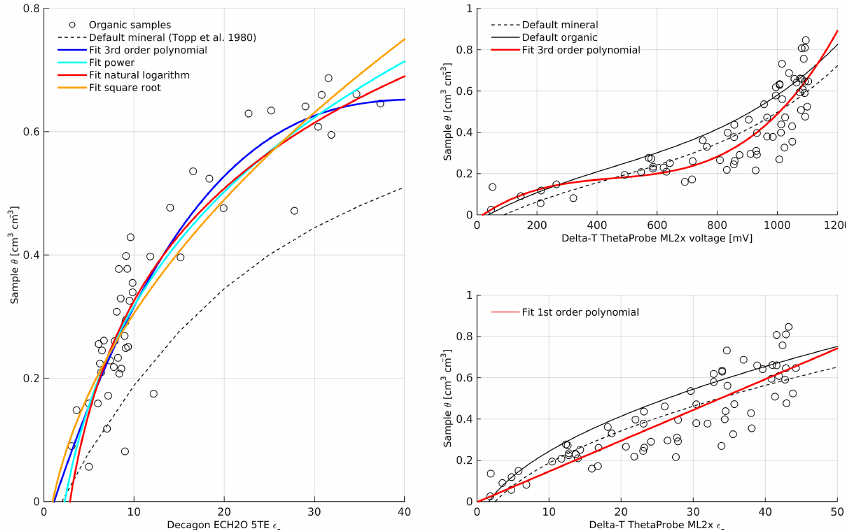
Figure 3. Fitting functions for the Decagon 5TE apparent relative permittivity ε a (left panels), and ThetaProbe voltage (mV) (upper right panel) as well as ε a (lower right panel) against volumetric moisture content θ including manufacturer’s default calibration curves for the organic soil layers (SOM >